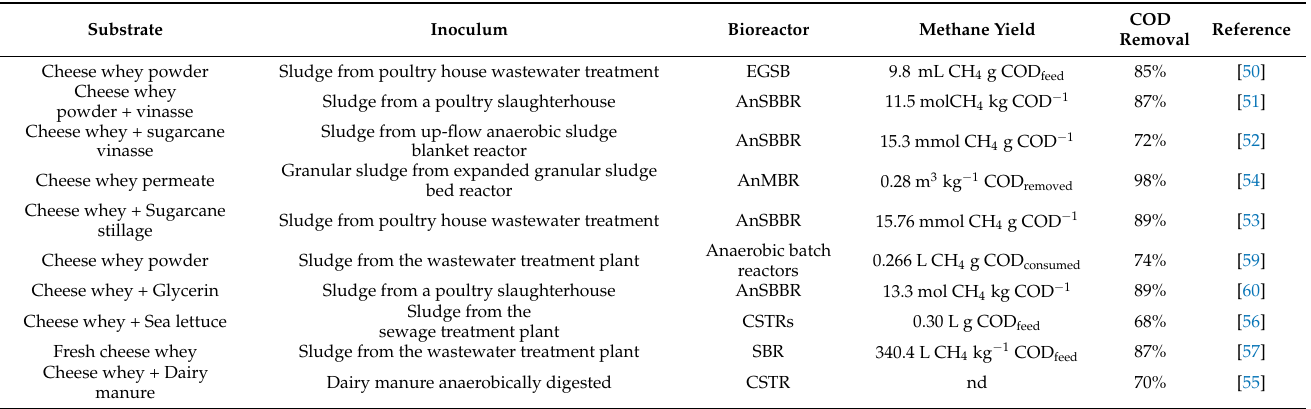
Table 3. Biomethane production using cheese whey as the only substrate and in co-digestion mode using some agro-industrial